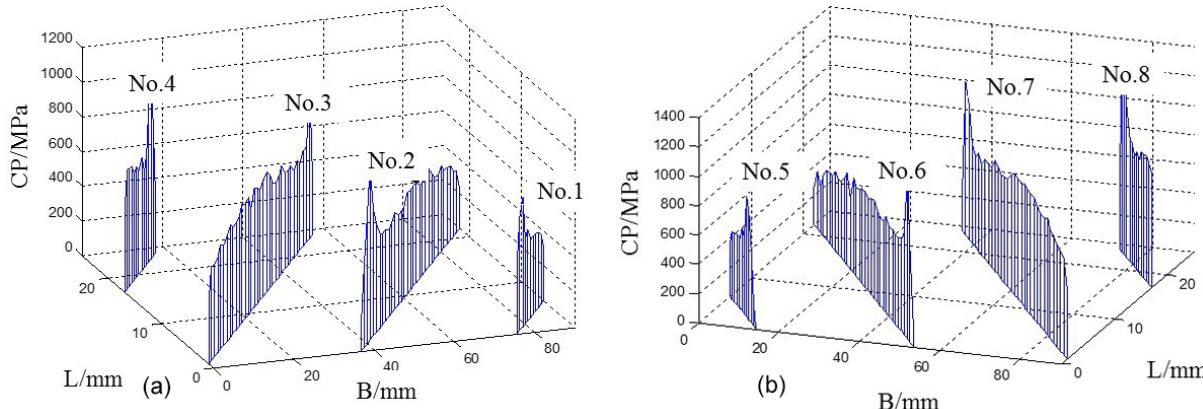
Figure 18. Contact stress distribution of the tooth surface with the stiffness of the no. 3 shaft section. (a) Left tooth surface. (b) Right tooth surface.